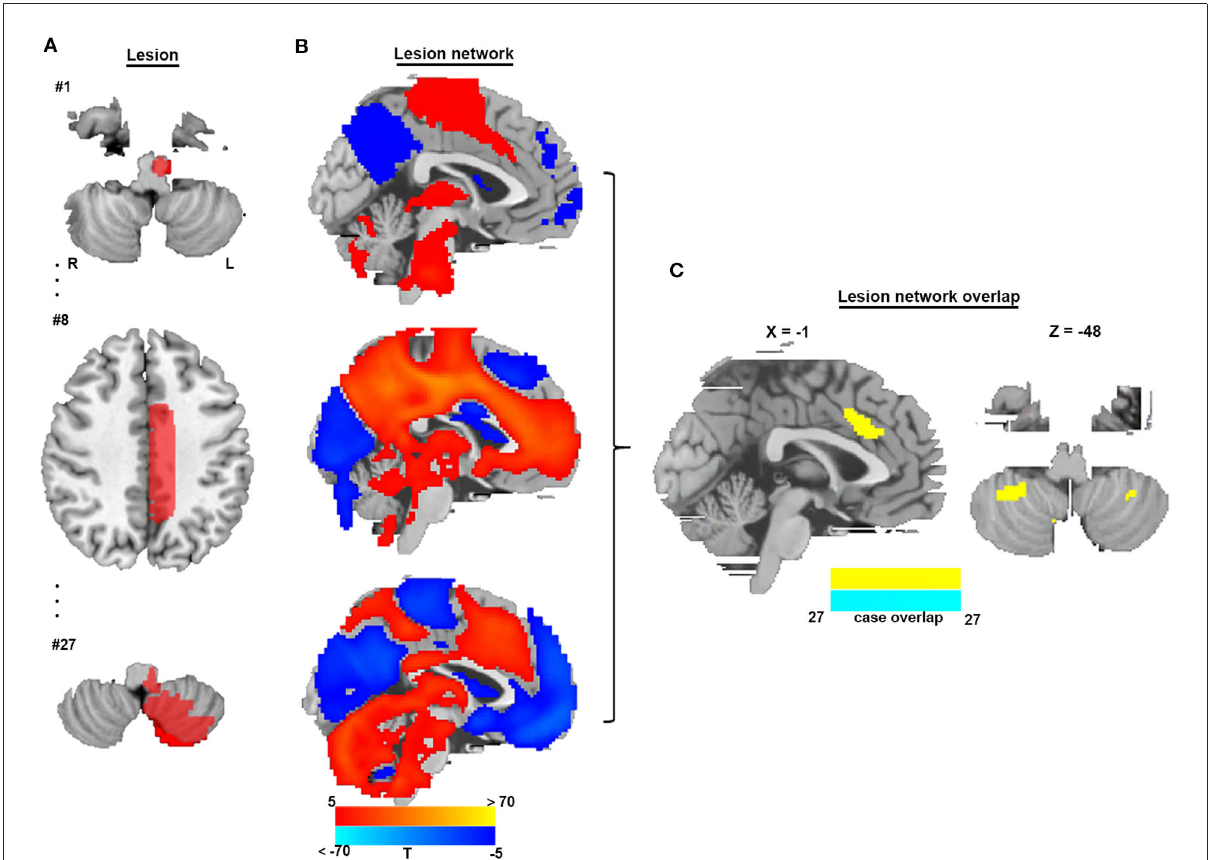
FIGURE3 Lesion network mapping of CSA. (A) Three representative lesions of a total of 27 were traced onto a standardized MNI brain template. (B) Brain regions functionally connected to each lesion location were calculated using a large resting-state functional connectivity database from HCP ( n = 1,083). (C) Overlap of thresholded functional connectivity maps ( t ≥ |5|) from each lesion-identified brain region connected to all lesion